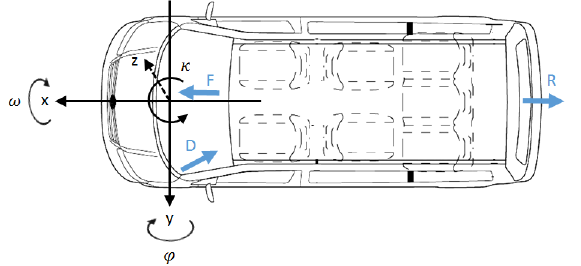
Figure 3: Vehicle coordinate system. Origin is the center of the front axle. Y-axis is equal to front axle, x-axis through front and rear axle and orthogonal to y-axis. Z-axis is orthogonal to the other two axes. Vehicle cameras of the test car are shown in blue (F = front, D = driver, R = rear), position of the cameras at the arrow tail, viewing direction like arrows (Volkswagen,